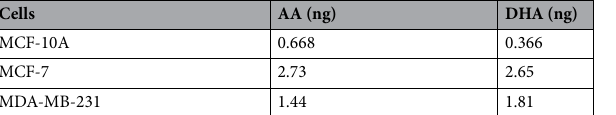
Table 2. Endocannabinoid levels of Arachidonic acid (AA) and Docosahexaenoic acid (DHA) determined for breast cancer cells. Values are in ng/10 6 cells.